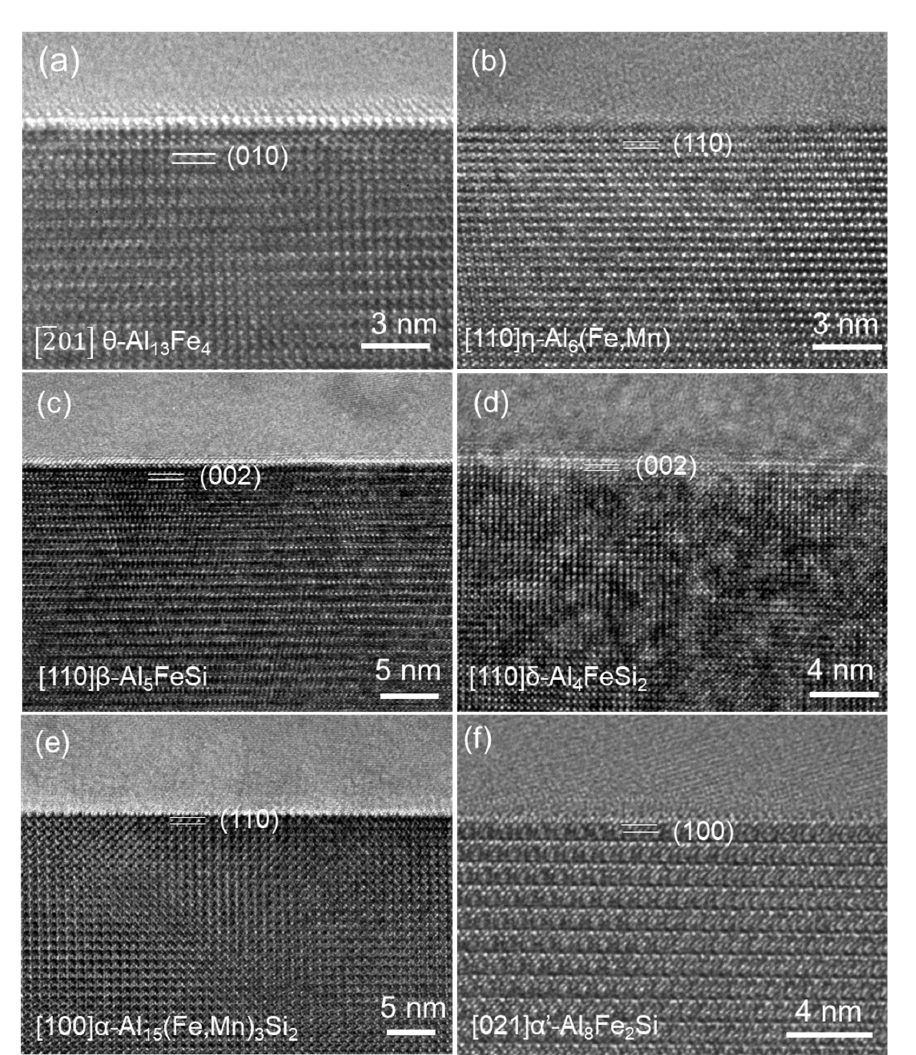
Figure 3. High ‐ resolution transmission electron microscopy (HRTEM) images showing the faceted Figure 3. High-resolution transmission electron microscopy (HRTEM) images showing the faceted planes of ( a ) θ‐ Al 13 Fe 4 with (010) facet in Al ‐ 1.0Fe binary alloy cast from 720 °C [80]; and ( b ) planes of ( a ) θ -Al 13 Fe 4 with (010) facet in Al-1.0Fe binary alloy cast from 720 ◦ C [80]; and ( b ) η - η‐ Al 6 (Fe,Mn), (110) faceted when viewed along the [110] zone direction in Al ‐ 2Mn ‐ 1Fe cast from Al 6 (Fe,Mn), (110) faceted when viewed along the [110] zone direction in Al-2Mn-1Fe cast from 720 °C [83]; ( c ) β‐ Al 5 FeSi with (002) facet in Al ‐ 12Si ‐ 0.6Mn ‐ 2.8Fe alloy, cast from 700 °C; ( d ) δ‐ Al 4 FeSi 2 with (002) facet in Al ‐ 16Si ‐ 5Fe alloy cast from 720 °C; ( e ) α‐ Al 15 (Fe,Mn) 3 Si 2 with (110) 720 ◦ C [83]; ( c ) β -Al 5 FeSi with (002) facet in Al-12Si-0.6Mn-2.8Fe alloy, cast from 700 ◦ C; ( d ) δ - facet in Al ‐ 5Mg ‐ 2Si ‐ 0.7Mn ‐ 1.3Fe alloy cast from 720 °C [31]; and ( f ) α ’ ‐ Al 8 Fe 2 Si with (100) faceted in Al 4 FeSi 2 with (002) facet in Al-16Si-5Fe alloy cast from 720 ◦ C; ( e ) α -Al 15 (Fe,Mn) 3 Si 2 with (110) facet Al ‐ 4Fe ‐ 4Si alloy cast from 760 °C. All alloys were cast at 3.5 K/s. in Al-5Mg-2Si-0.7Mn-1.3Fe alloy cast from 720 ◦ C [31]; and ( f ) α ’-Al 8 Fe 2 Si with (100) faceted in Al-4Fe-4Si alloy cast from 760 ◦ C. All alloys were cast at 3.5